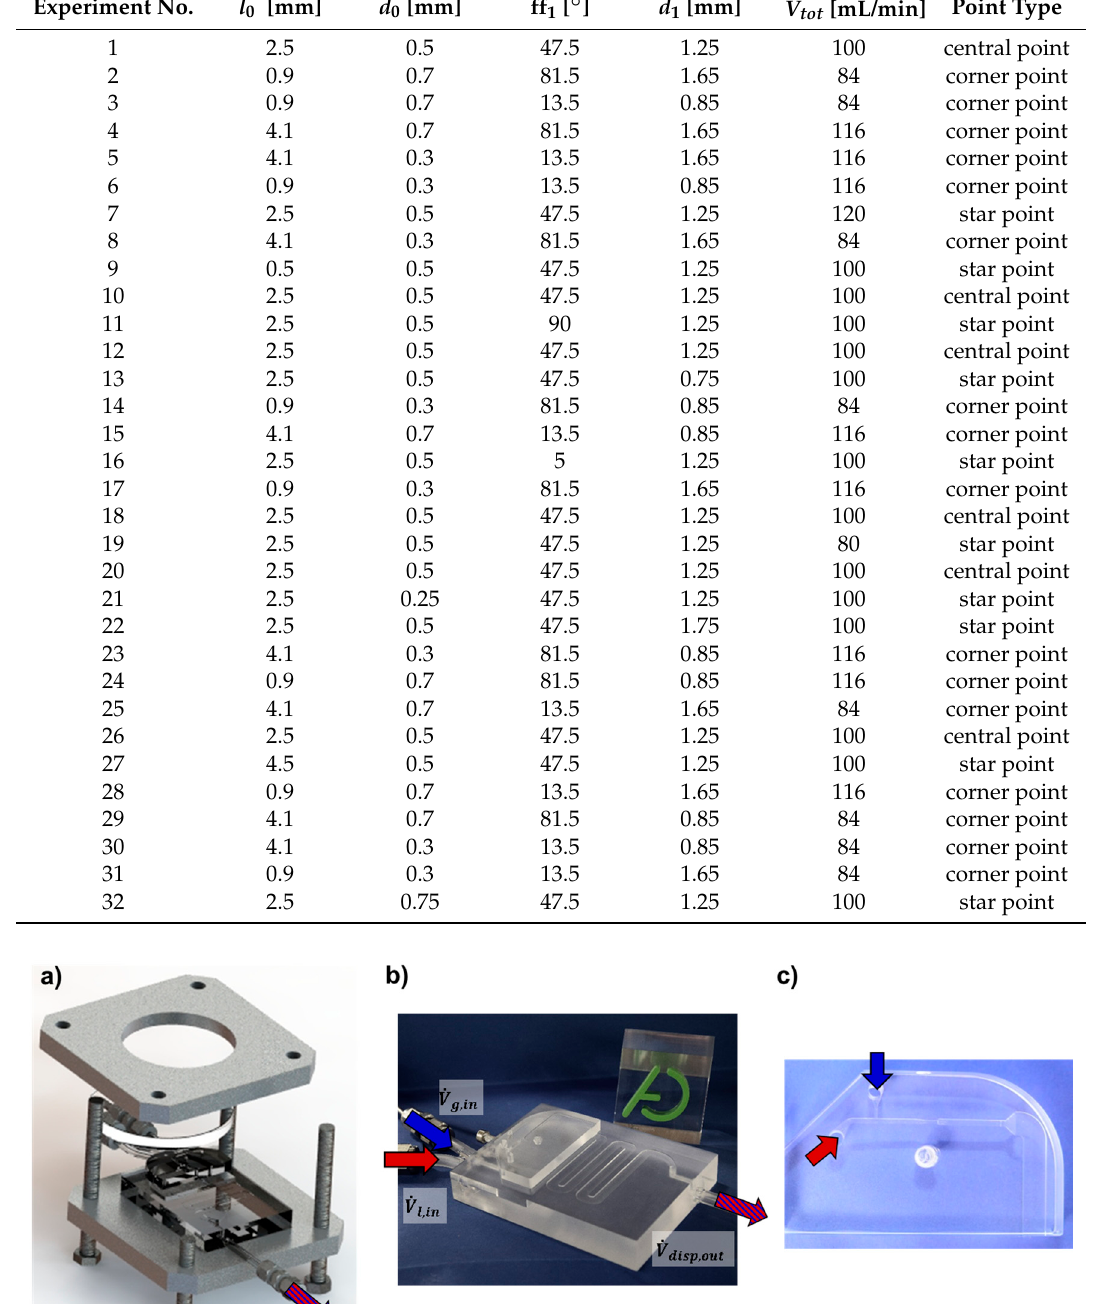
Figure 5. ( a ) 3D model of the microreactor set-up with reaction plate, exchangeable nozzle element, view glass, and outer flanges; ( b ) reaction plate and nozzle insert made from PMMA; ( c ) exchangeable inlet element with micronozzle.